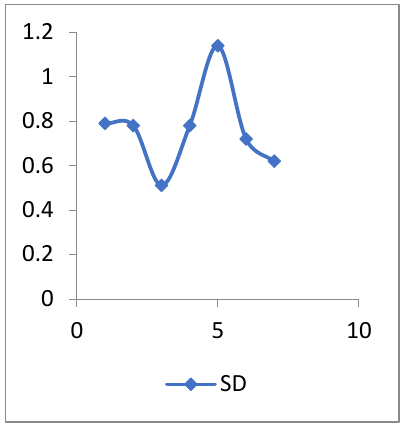
Figure 9. The SD values of general health data.